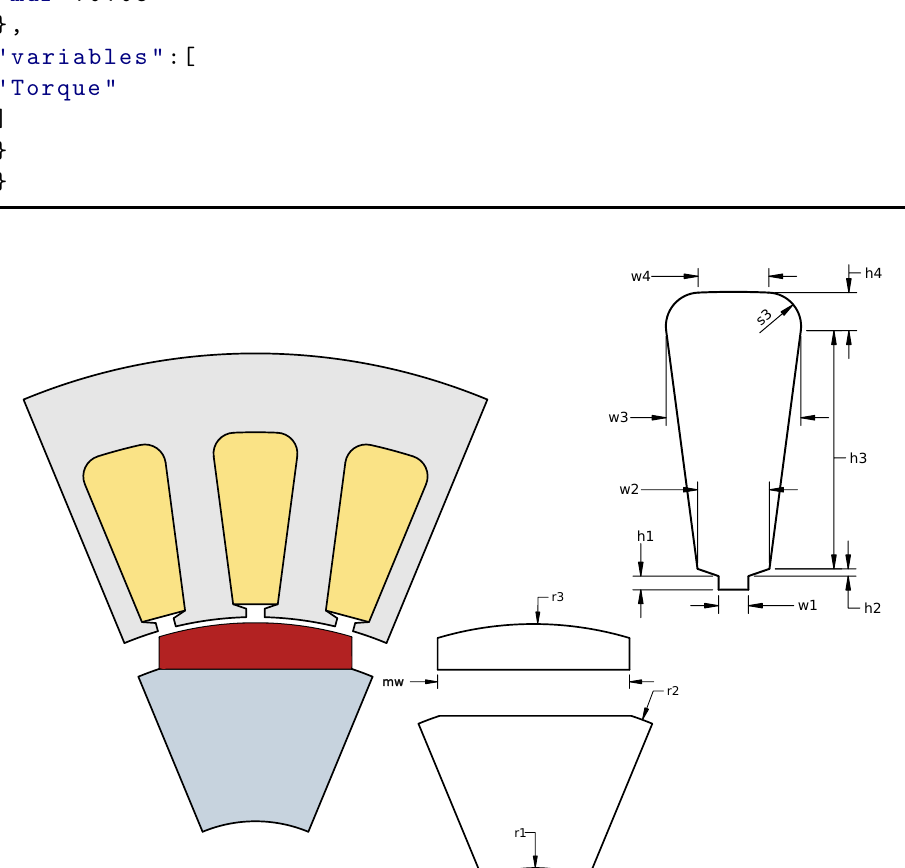
Figure 5. The geometry of the analyzed BLDC machine, which is built from the colored segments of the machines via the Digital-Twin-Designer. The right side of the image shows the parameterization of these different